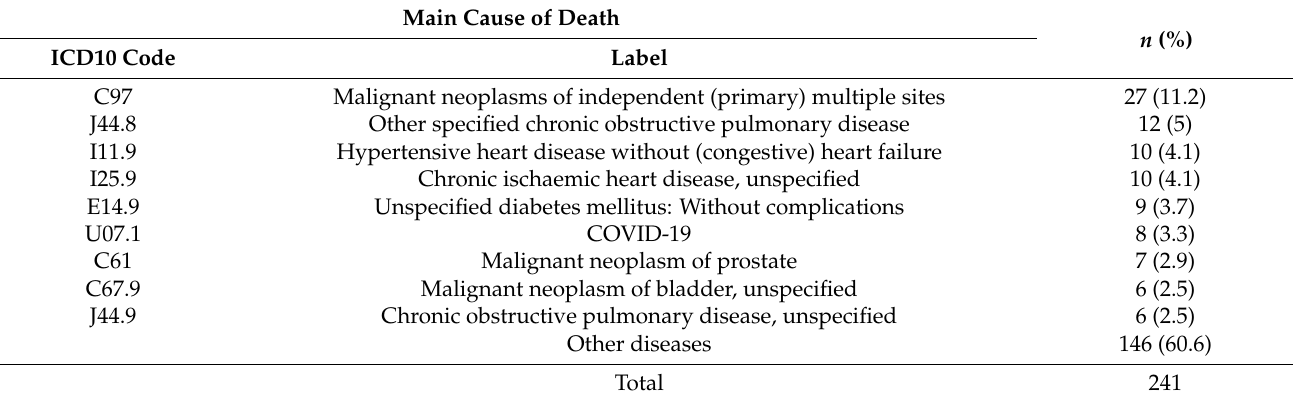
Table 2. Counts and percentages of main causes of death in records where lung cancer was a secondary